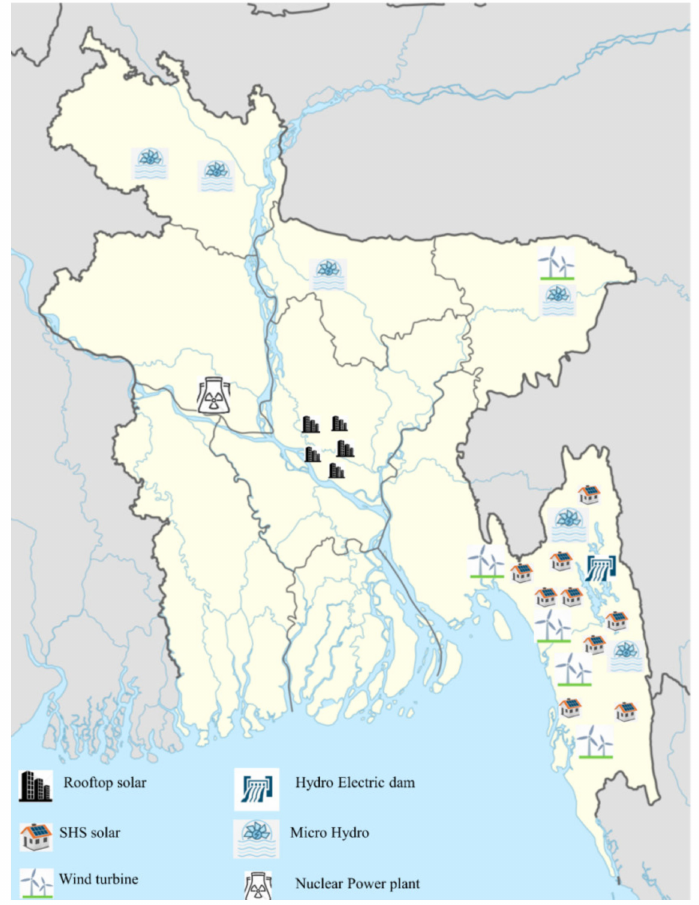
Figure 8. Map of Bangladesh and its renewable energy